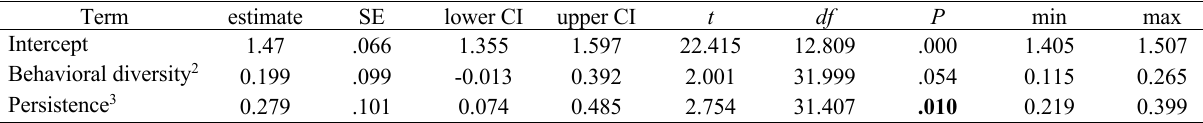
Note. 1 Results displayed are estimates and standard errors, together with confidence limits, results of tests, and the range of estimates obtained when dropping levels of random effects one at a time, 2 z -transformed to a mean of 0 and a standard deviation of 1; mean and SD of the original variable were .645 and .242, respectively and 3 z -transformed to a mean of 0 and a standard deviation of 1; mean and SD of the original variable were .794 and .539, respectively.